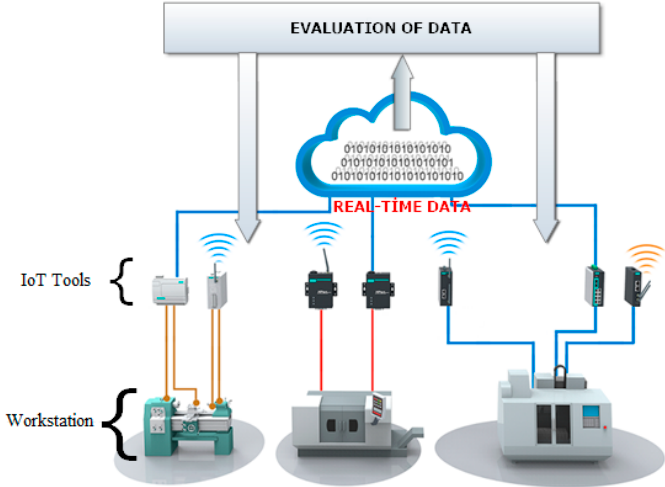
Figure 1. Functioning of the system.